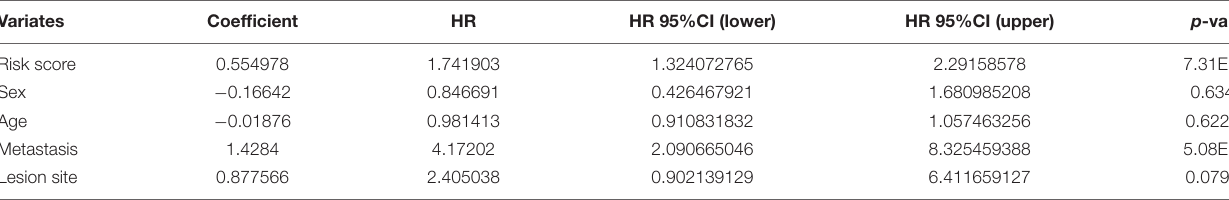
TABLE 3 | Multivariate analysis of risk score and characteristics in training cohort.